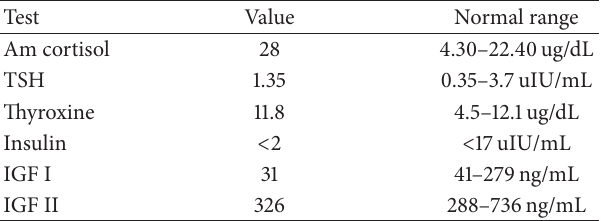
Table 2: Workup for hypoglycemia.